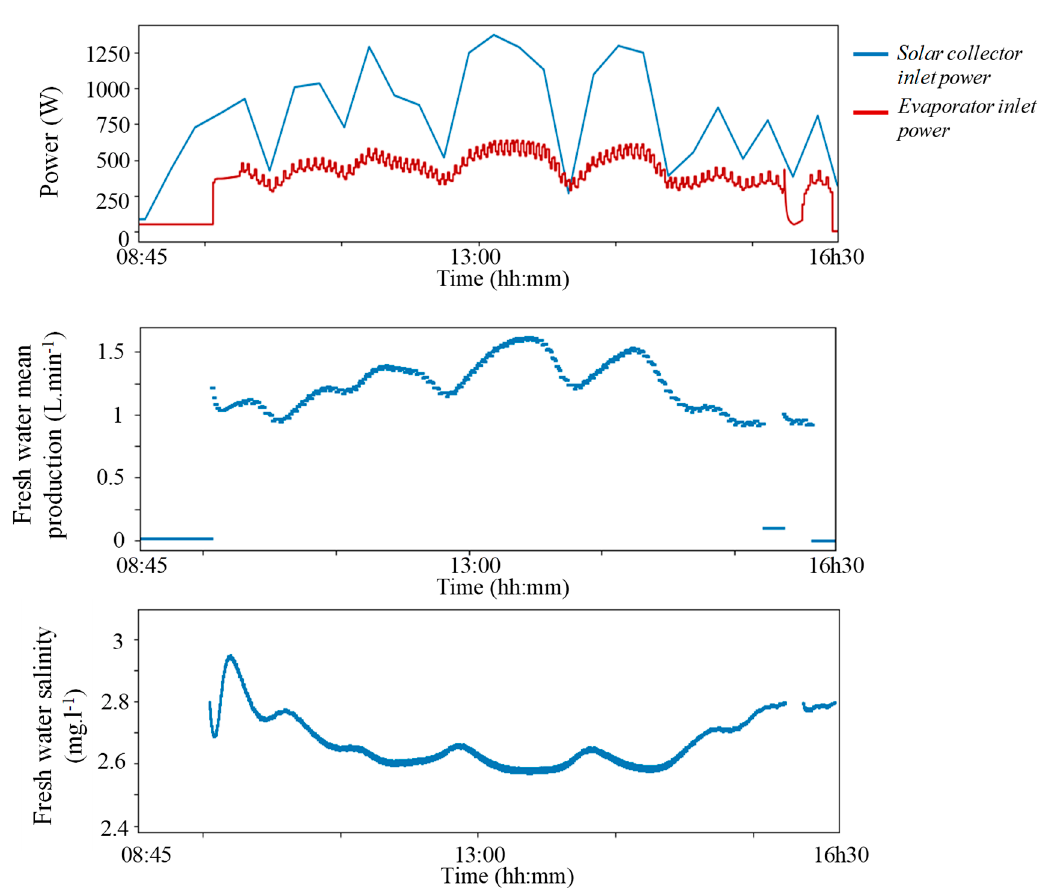
Figure 21. Simulated fresh-water production and quality during a disturbed and cloudy day.